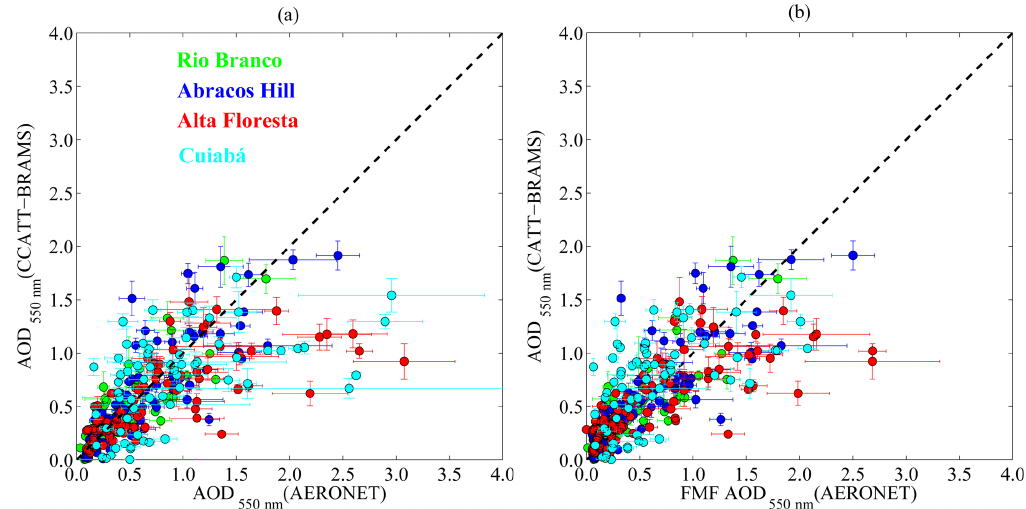
Fig. 4. Modeled daily mean aerosol optical depth at 550nm (AOD 550nm CCATT-BRAMS) versus observed (a) total and (b) fine mode fraction (FMF) AOD 550nm (AERONET) over AERONET sites. Bars consist of standard deviation and represent daytime variability of